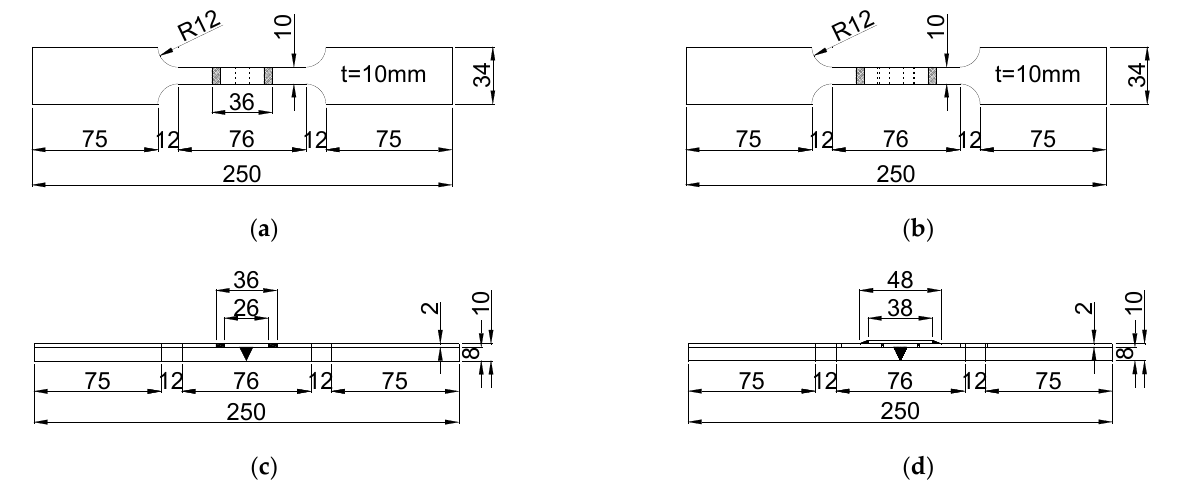
Figure 5. Manufacture of test coupons from TC bimetallic steel welding plates.